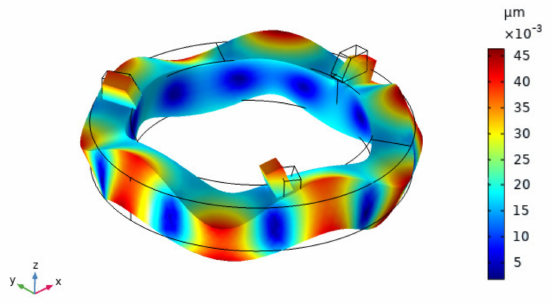
Figure 5. The modal shape of the ring-shaped piezoelectric transducer at a frequency of 93.2 kHz. Lastly, modal shapes of unimorph actuator were analyzed when the disc and triangle-shaped flanges were used. The needed modal shapes were determined at the frequencies of 94.8 kHz and 95.3 kHz for the actuators with a disc and triangle-shaped flanges, as shown in Figure 6. Contact elements are displaced in radial and axial directions; therefore, the contact point moves in the XZ plane and these modes of vibrations and can be used for rotor